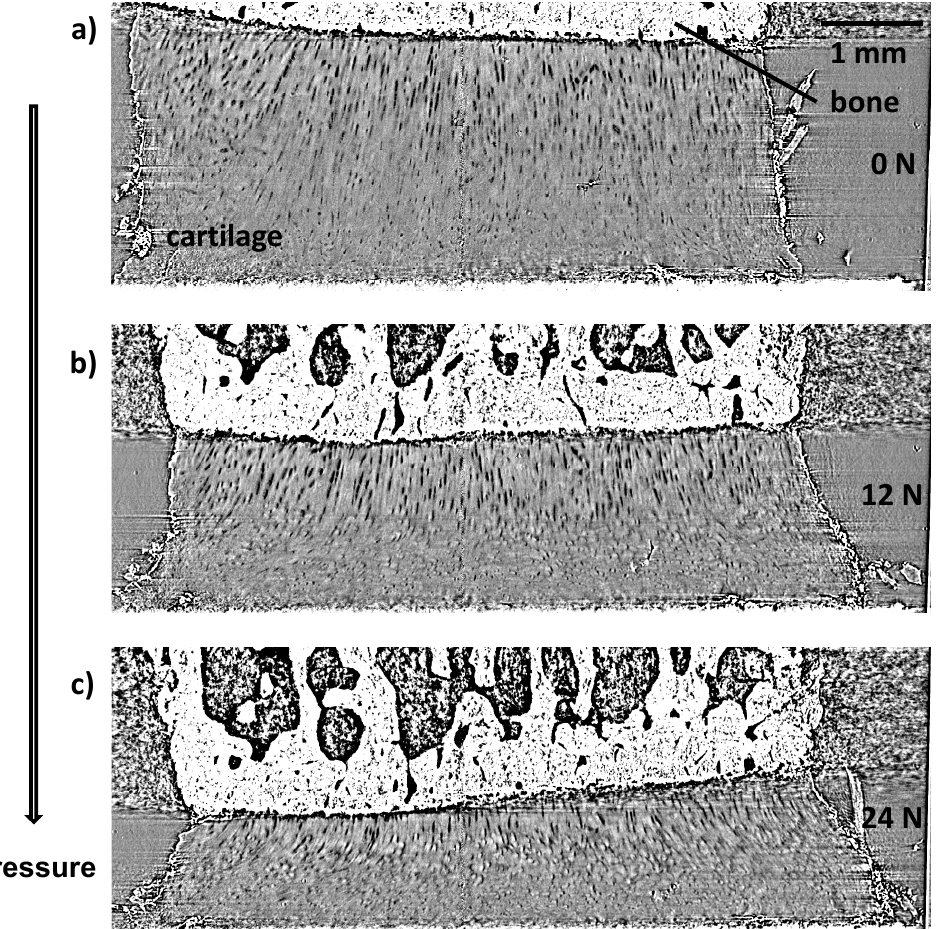
Figure 5. Sagittal views of an osteochondral plug under load: ( a ) cartilage plug without load, ( b ) cartilage plug with 12 N (medium) axial load and ( c ) cartilage plug with 24 N (maximum) axial